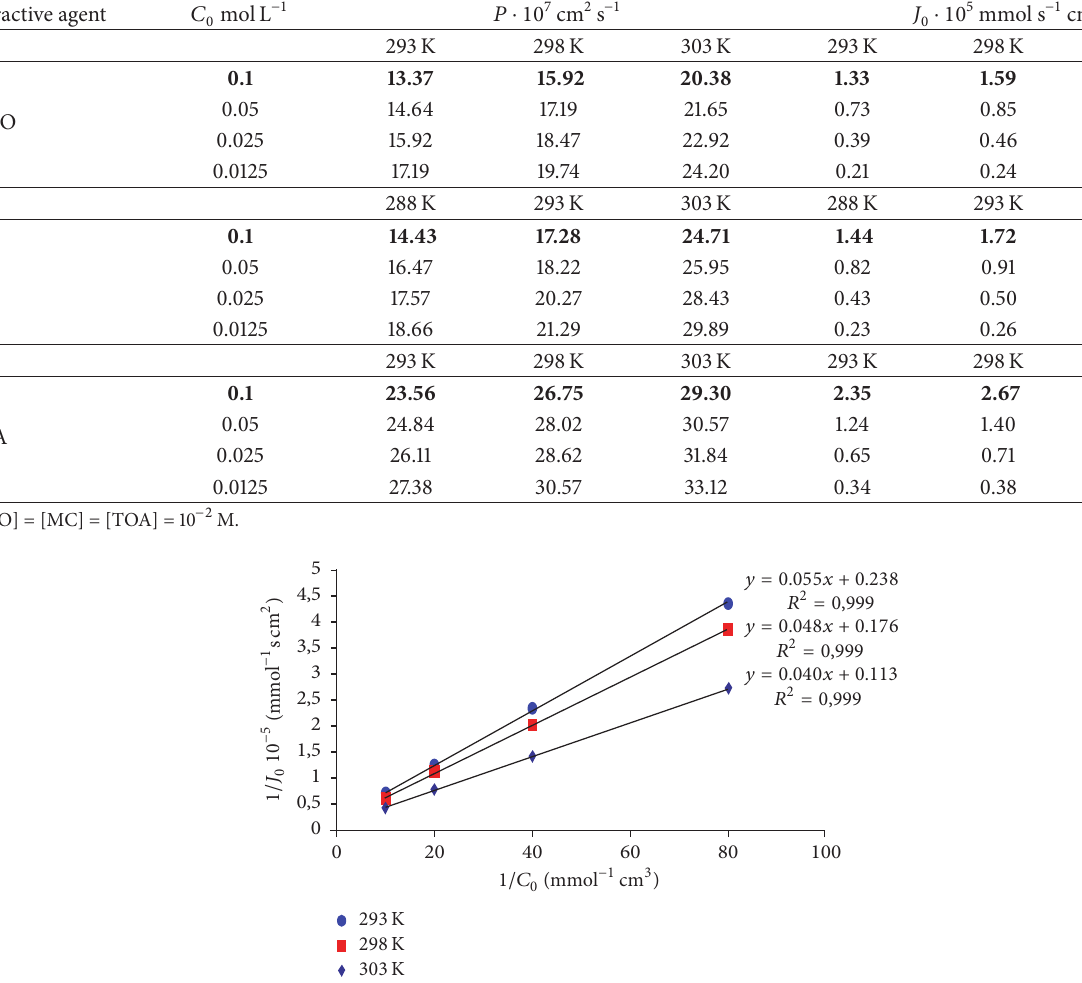
Figure 12: Lineweaver-Burk lines for the facilitated extraction of VO 2+ ions by SLM-RESO membrane, for different values of temperature. [H 3 O + ] = 1M, [RESO] = 10 −2 M.